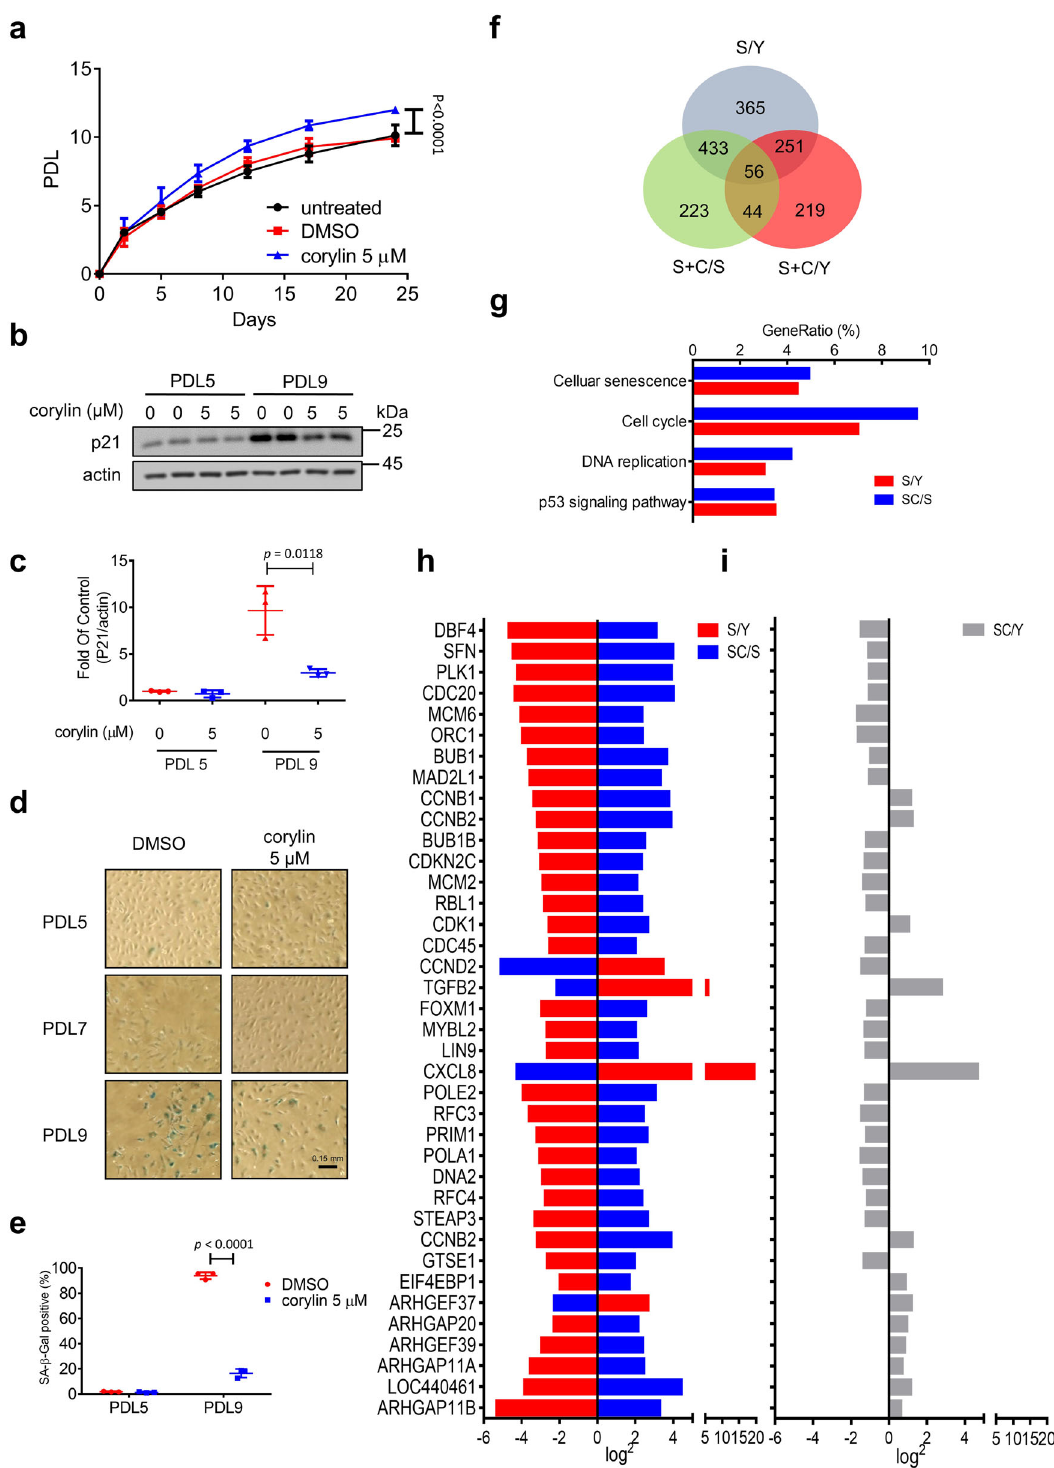
Mother enrichment program . The liquid aging assay was performed as previously described 12 . Brie fl y, cells were cultured at 30°C in YEPD medium overnight, and the cultures were diluted to A 600 = 0.25 and recovered to the log phase. Cultures were counted and inoculated in culture tubes at a cell density of 2 × 10 3 cells/ml. The mixtures contained 17 β -estradiol at a fi nal concentration of 1µM, and they were incubated in a roller drum at 50rpm and 30°C for 60h. Each group was monitored We used the OpenCFU 3.8 software to calculate